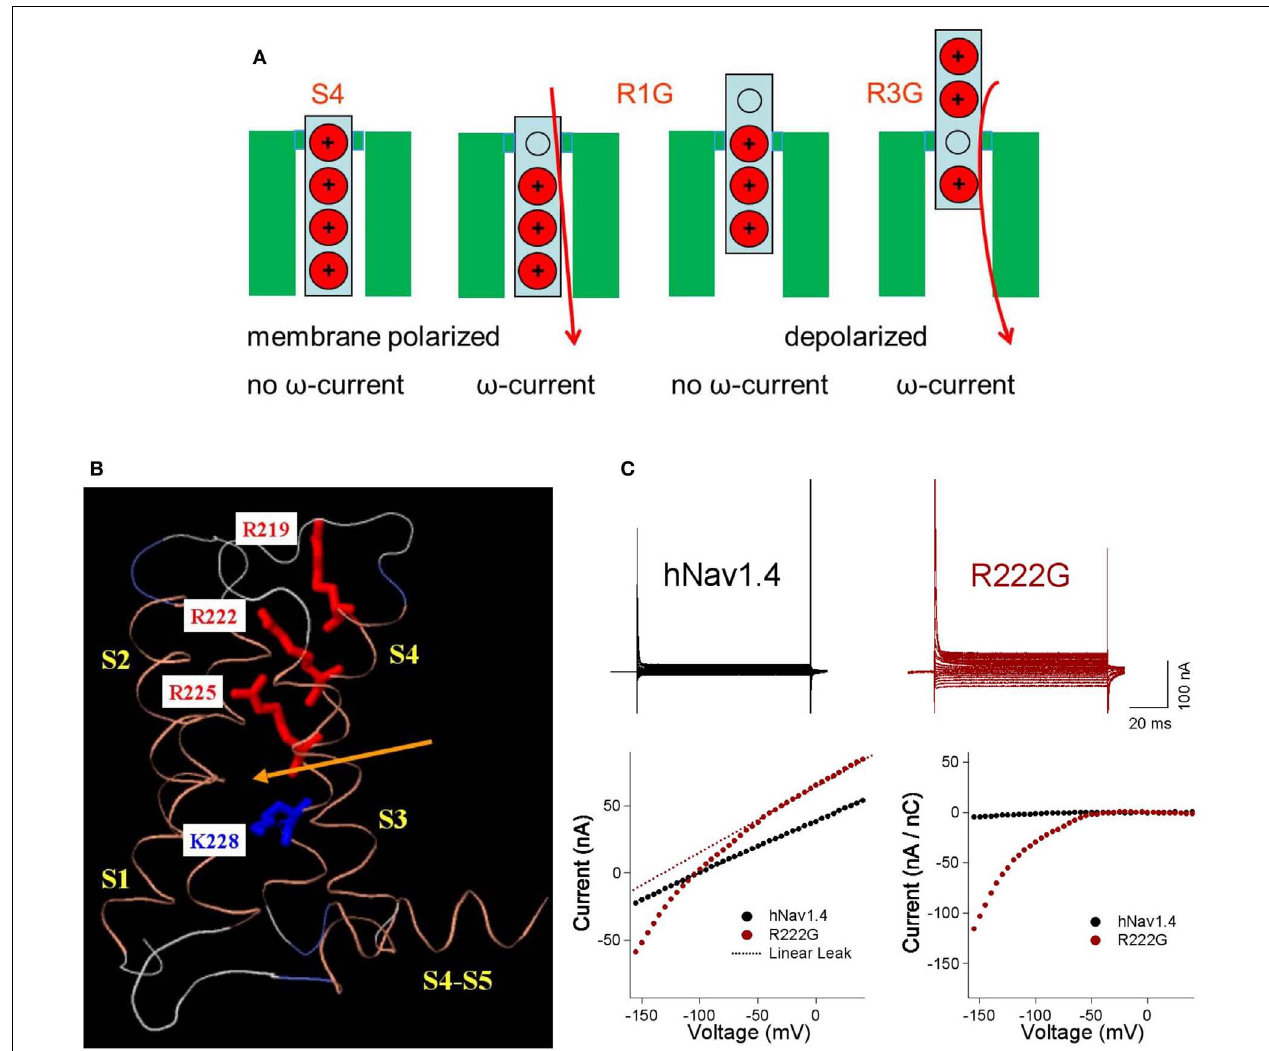
FIGURE 2 | Omega pores and currents dependent on the R position. (A) Replacement of the outermost arginine (red) by a neutral amino acid (gray) such as glycine (R1G) opens a conductive pathway through the polarized membrane, resulting in an omega current (red). At depolarized potentials at which the S4 segment moves outward, the conductive pathway is closed by a deeper arginine and the omega current ceases. In contrast the replacement of a deeper arginine (R3G) only opens the omega pore if the membrane is depolarized. (B) Homology model of domain I in hNa v 1.4 based on crystal